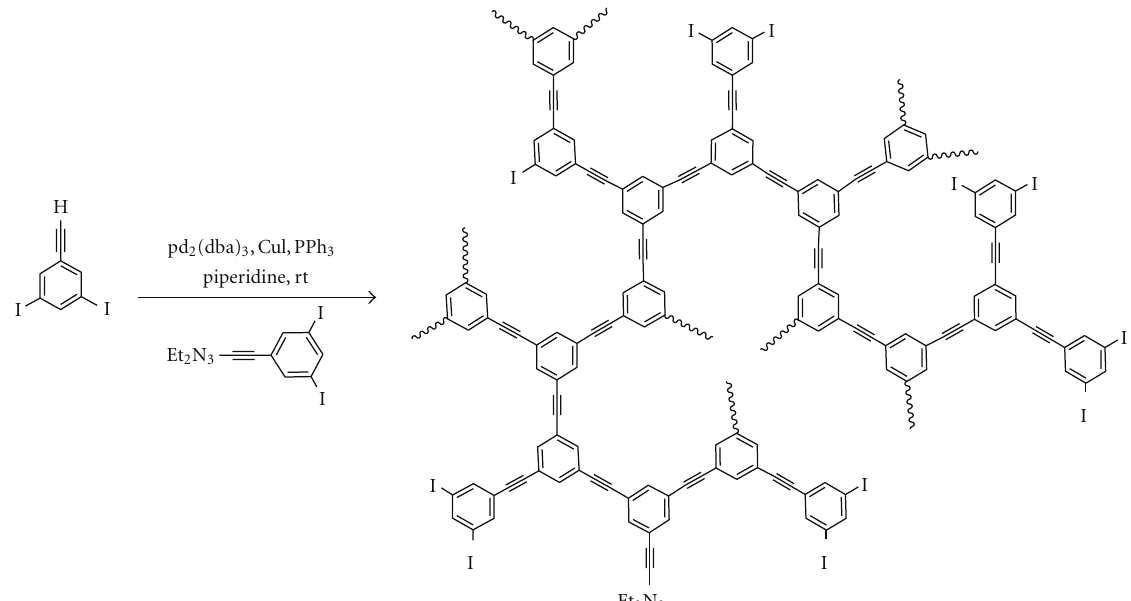
Scheme 1: Synthesis of hyperbranched